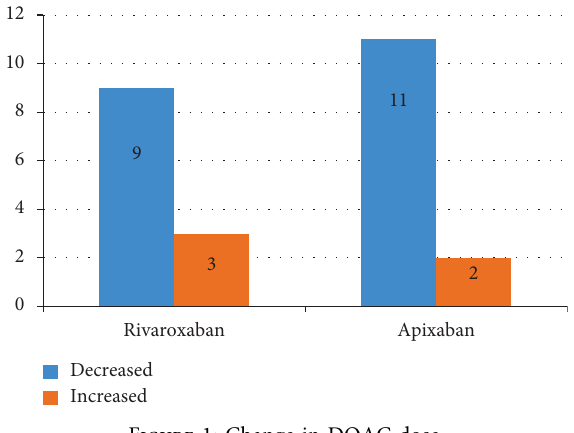
Figure 1: Change in DOAC